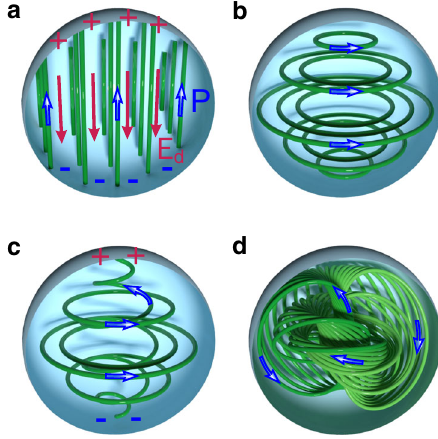
Fig. 1 Formation of the Hop fi on. a A uniform distribution of the polarization, P , (green lines) in a spherical nanoparticle, blue arrows showing polarization direction. Positive and negative depolarization charges on the surface induce depolarization electric fi eld, E d (red lines). b Polarization vortex. c Escape of the polarization vortex into the third dimension. d Polarization Hop fi